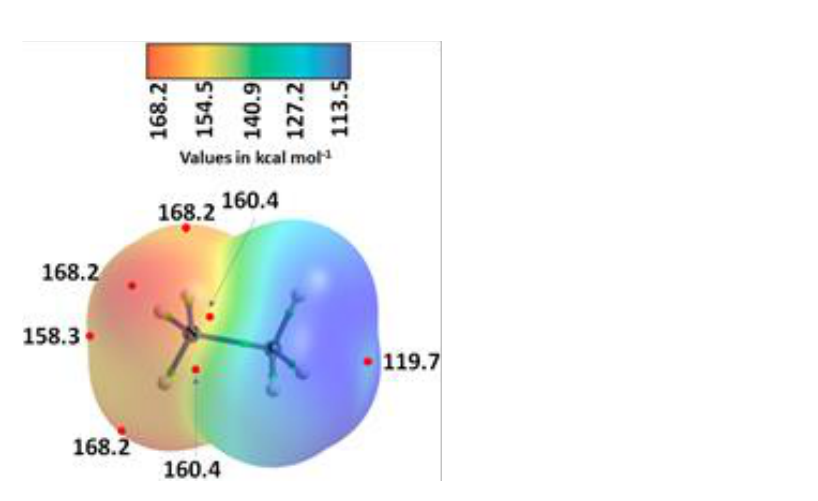
Table 1. Uncorrected and BSSE corrected Self-Consistent Fieldinteraction energies ( E int and E int (BSSE), respectively) of H 3 C-H 3 N···I and H 3 N-H 3 C···I ion-pairs, obtained on the fixed crystal ge- ometry, as well as that on the MP2(FC)/TZVPPD and ω B97X-D/TZVPPD optimized geometries. Val- ues are in kcal mol −1 a .